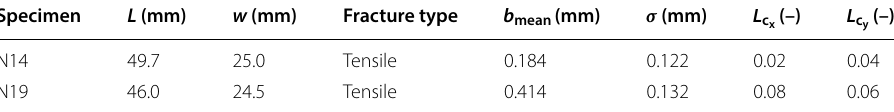
Physical properties of the specimens under investigation, where L and w are the length and width of the aperture field of the specimen, respectively, b mean and σ are the mean and the standard deviation of the aperture distributions, respectively, L c x is the normalized correlation length in the flow direction, and perpendicular to the flow